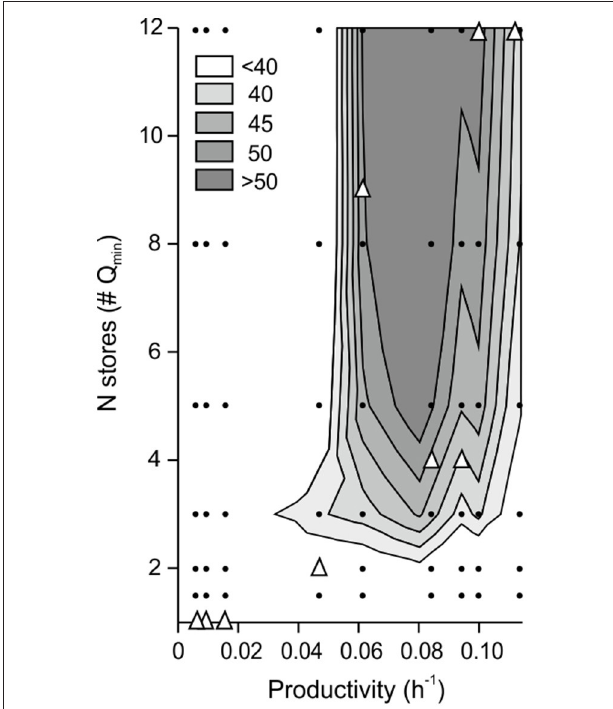
FIGURE 4 | Sensitivity analysis showing the effect of varying ecosystem productivity and internal nitrate stores on ( P exp / P obs ) − ( P random / P obs ), a measure of selection effect. Contour lines represent the enhancement of productivity (%) associated with selection effect. Data used to compose the figure (small dots) and data derived from field measurements (triangles) are also